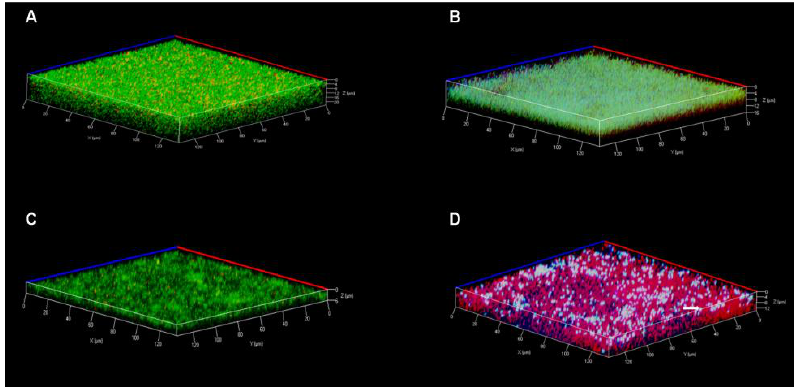
Figure 7. Confocal microscopic analysis of antibiofilm capability of the 17BIPHE2-tobramycin